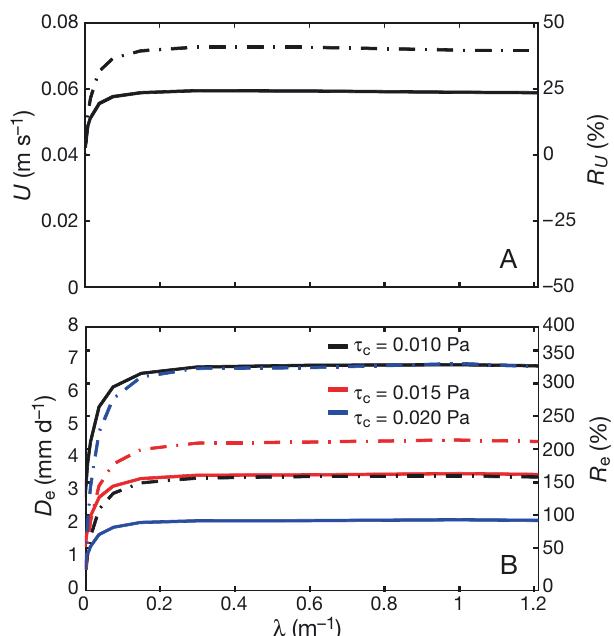
Fig. 7. (A) Bottom speed ( U) and (B) erosion rate ( D e ) versus the drag coefficient ( λ ) of the fish cages. Solid line: bottom speed/erosion (scale on left); dashed line: relative ratio ( R U and